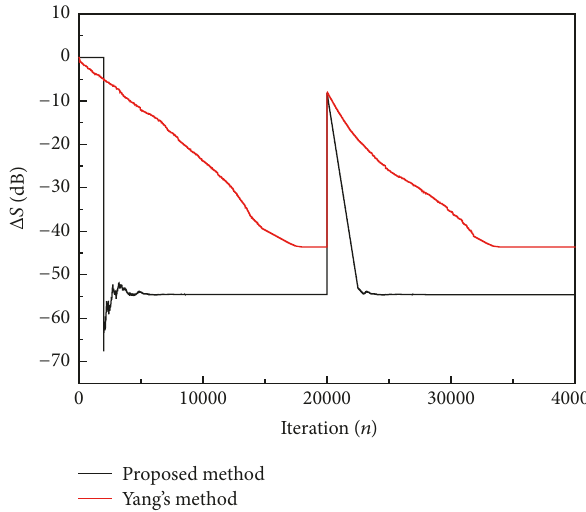
Figure 11: Performance comparison of error channel identification.